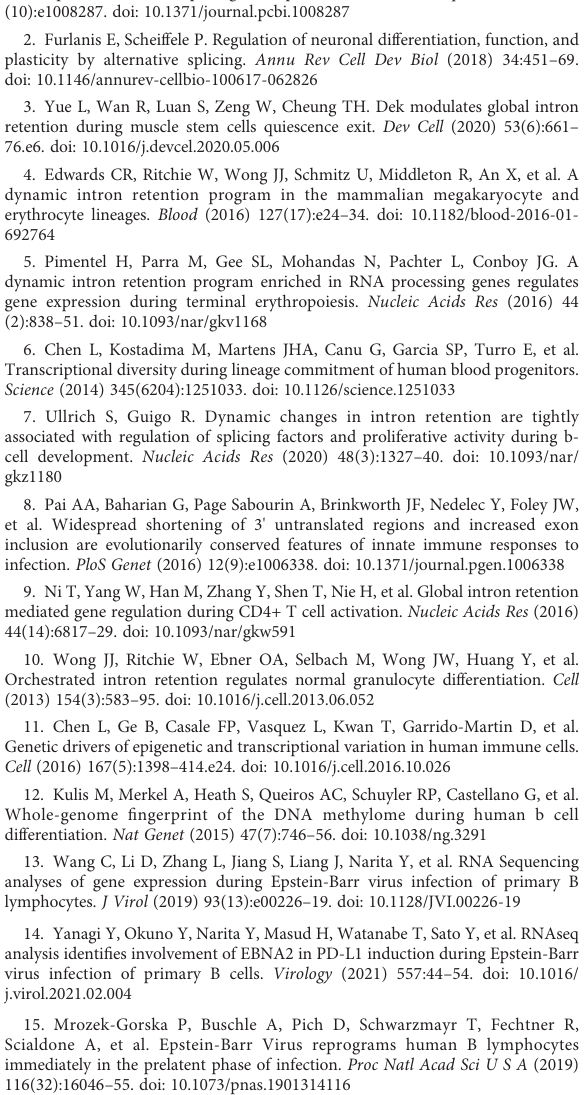
SUPPLEMENTARY TABLE 5 Hypergeometric test p-values for pairwise comparisons of exon inclusion changes in B cell differentiation, EBV infection of blood B cells, and RBP knockdowns. Log2(FoldChange) by sleuth of mRNA abundance, IncLevelDifference (SE_max_dPSI) by rMATS for exon usage and intron retention change (IR_max_dPSI) by IRFinder per gene in differentiated B cells compared to blood NBCs and in EBV-infected cells compared to parental blood NBCs. For genes with multiple splice junctions the SE and IR events with the highest absolute inclusion/retention difference measurable in all compared replicates are displayed. SUPPLEMENTARY TABLE 6 Hypergeometric test p-values for pairwise comparisons of intron retention changes in B cell differentiation, EBV infection of blood B cells, and RBP knockdowns.